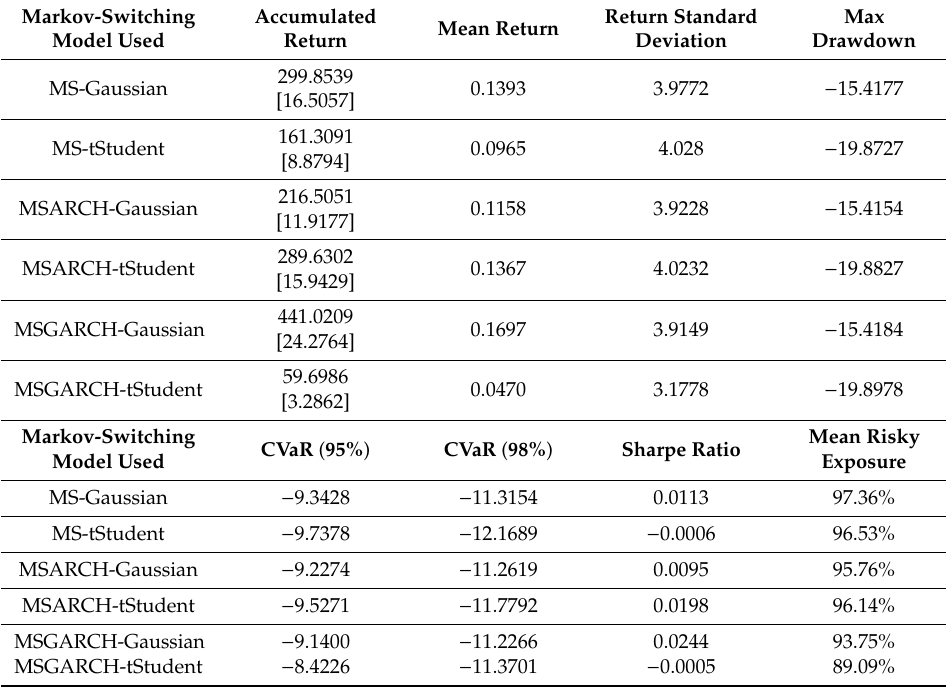
Table 7. Performance summary of the Markov-Switching investment strategy applied in the Brazilian stock market (from a U.S. dollar-based investor